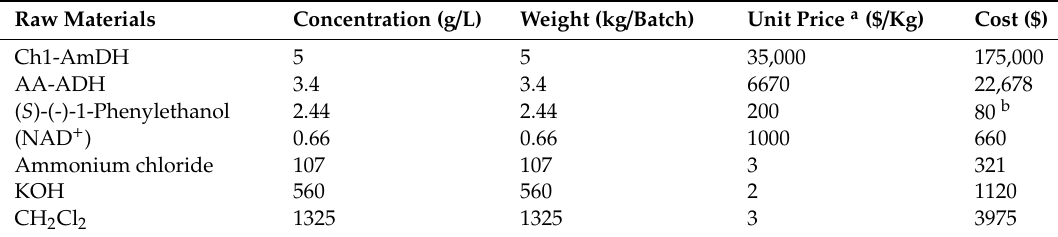
Table 5. Raw material costs per batch of reductive amination.